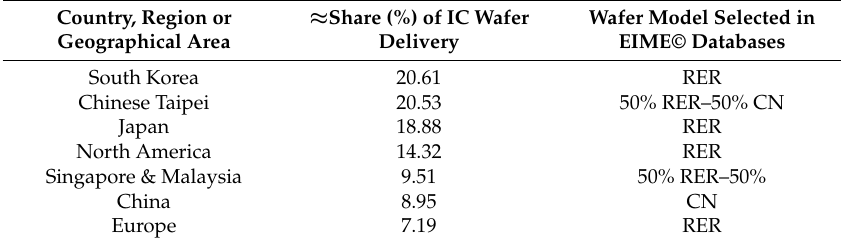
Table 6. Silicon wafer geographic distribution and modeling with the EIME©